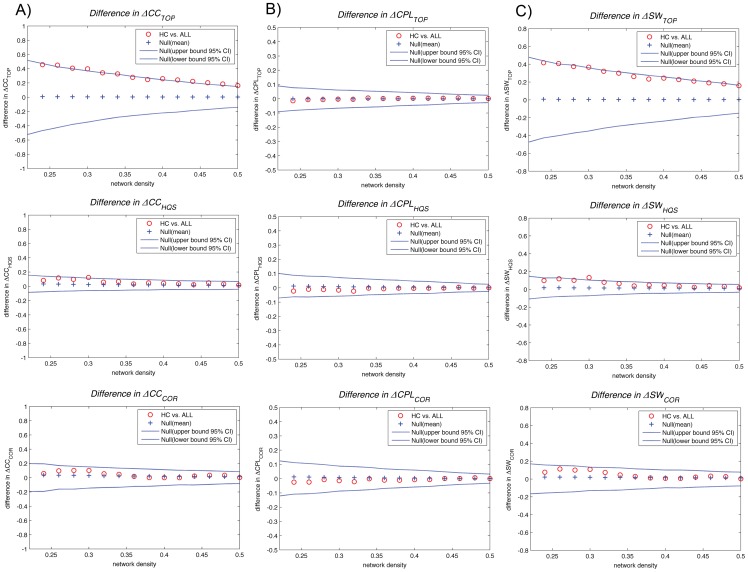
Between-group differences (HC vs. ALL) in small-world parameters.The 95% confidence intervals and between-group differences in A) normalized clustering (ΔCCTOP, ΔCCHQS, ΔCCCOR), B) normalized path length (ΔCPLTOP, ΔCPLHQS, ΔCPLCOR) and C) small-world index (ΔSWTOP, ΔSWQS, ΔSWCOR) as a function of network density for different benchmarking methods. The red circles show the difference between HC vs. ALL networks; the circles falling out of the confidence intervals (blue dashed lines) indicate the densities in which the difference is significant. The positive values indicate HC>ALL and negative values indicate HC<ALL.